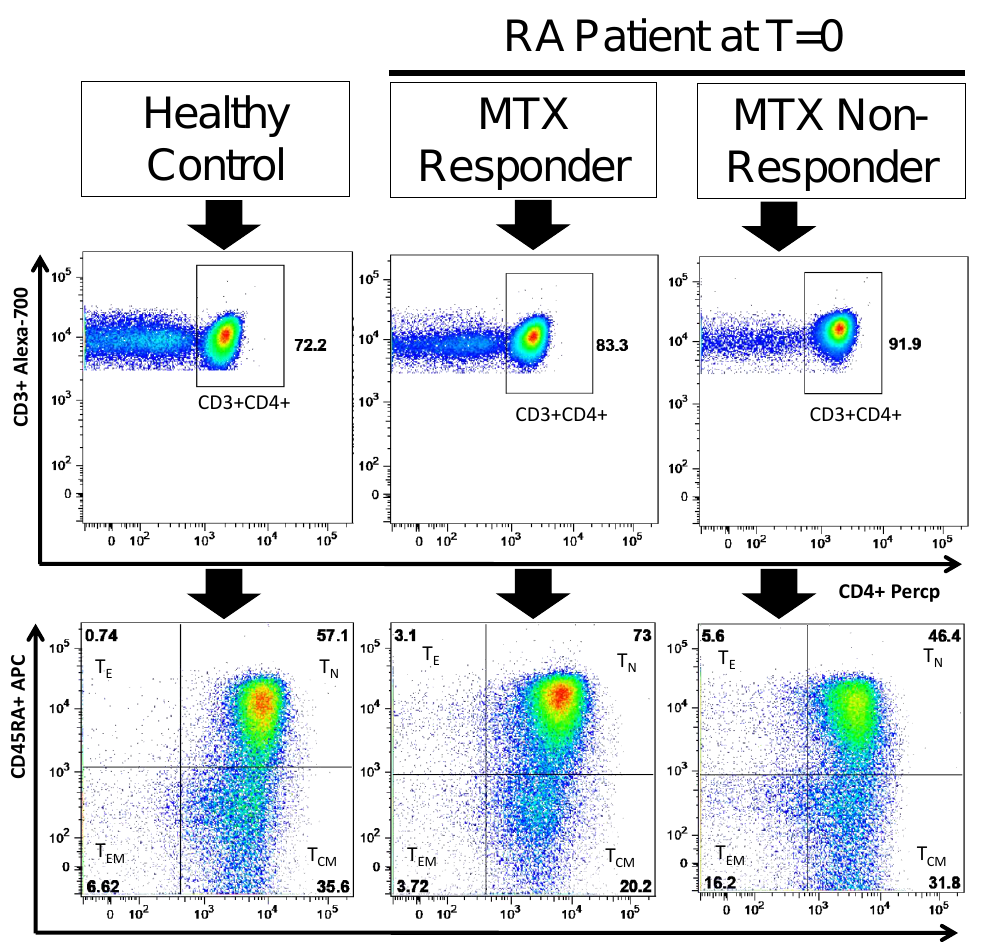
Figure 3. CD4 + T lymphocyte and their activation/differentiation stages in RA patients. Note . Dot plots represent the distribution of T CD4 + in percentages of naïve (T N ), central memory (T CM ), effector memory (T EM ) and effector (T E ) CD4 + T lymphocytes in a three representative situations: a healthy control, and a responder and non-responder RA patients at baseline of MTX treatment.